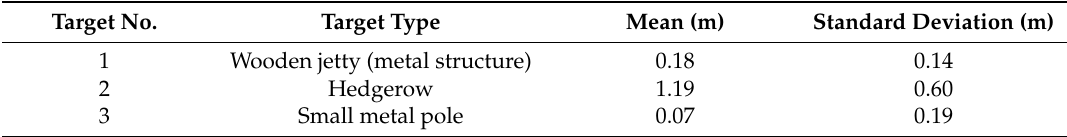
Table 8. Results of analysis of detection